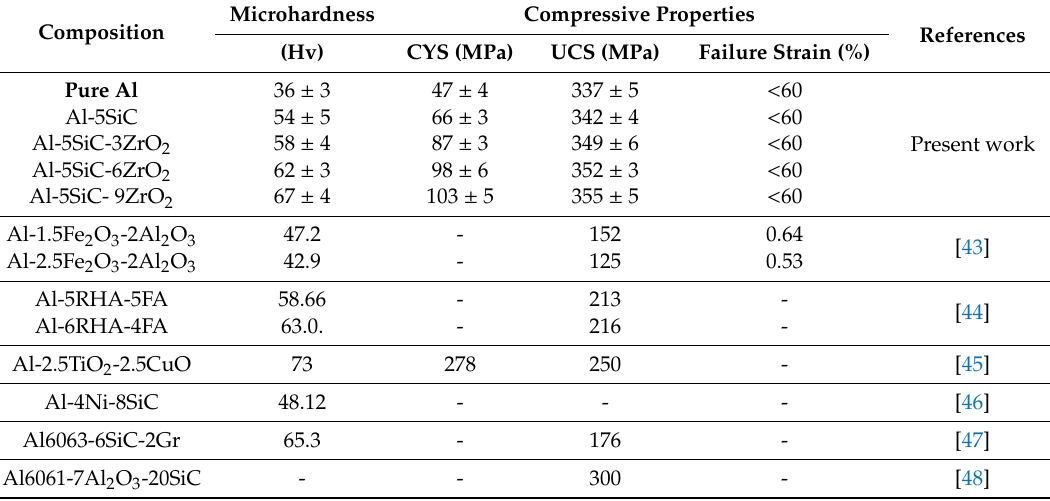
Table 2. Hardness and compressive properties of Al / SiC / ZrO 2 nanocomposites and their comparison with other nanocomposites.